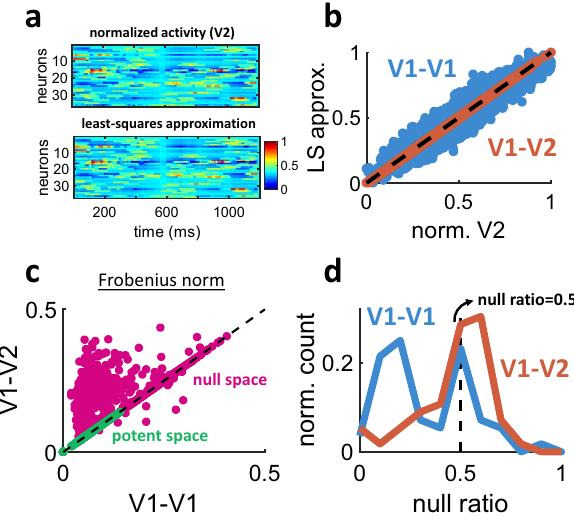
Figure 7. Null and potent modes estimated from simultaneous recordings of V1 and V2 activity. ( a ) Example of a single trial where V2 population activity was predicted by ridge regression of smoothed V1 activity recorded during the same trial. ( b ) Relation between V2 activity from panel ( a ) and its approximation by ridge regression. Individual circles are mean firing rates taken over 100 ms windows. Dashed line: unity. ( c ) Null and potent modes of V1-V1 and V1-V2 interactions. Individual circles are single trials. Each dot represents a value obtained from Eqs. (1–2). ( d ) Distribution of null ratios. Dashed line indicates a null ratio of 0.5, corresponding to an equivalent number of null and potent